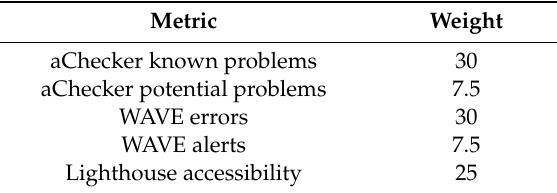
Table 3. Weights for the calculation of the website accessibility evaluation